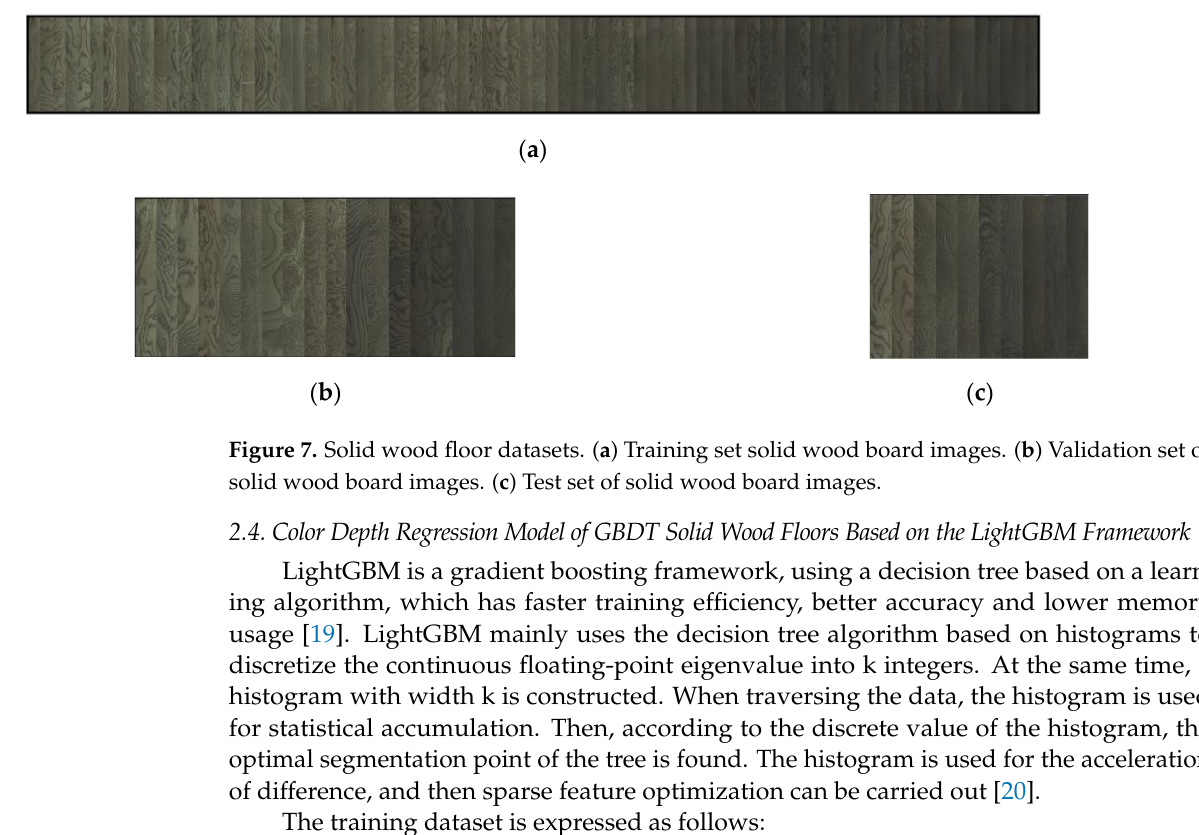
8 of 16 Figure 5. Sequence from shallow to deep solid wood floors. ( a ) Point1:0.33Point2:0.67 ( b ) Figure 6. Processing method for uneven sample numbers. ( a ) Color sequence of solid wood floors with uneven sample size. ( b ) Delineating demarcation point to realize the depth assignment of uneven solid wood floors. Because the numbers of the three kinds of solid wood floor color provided by solid wood floor manufacturers were equivalent, and the distribution was relatively uniform